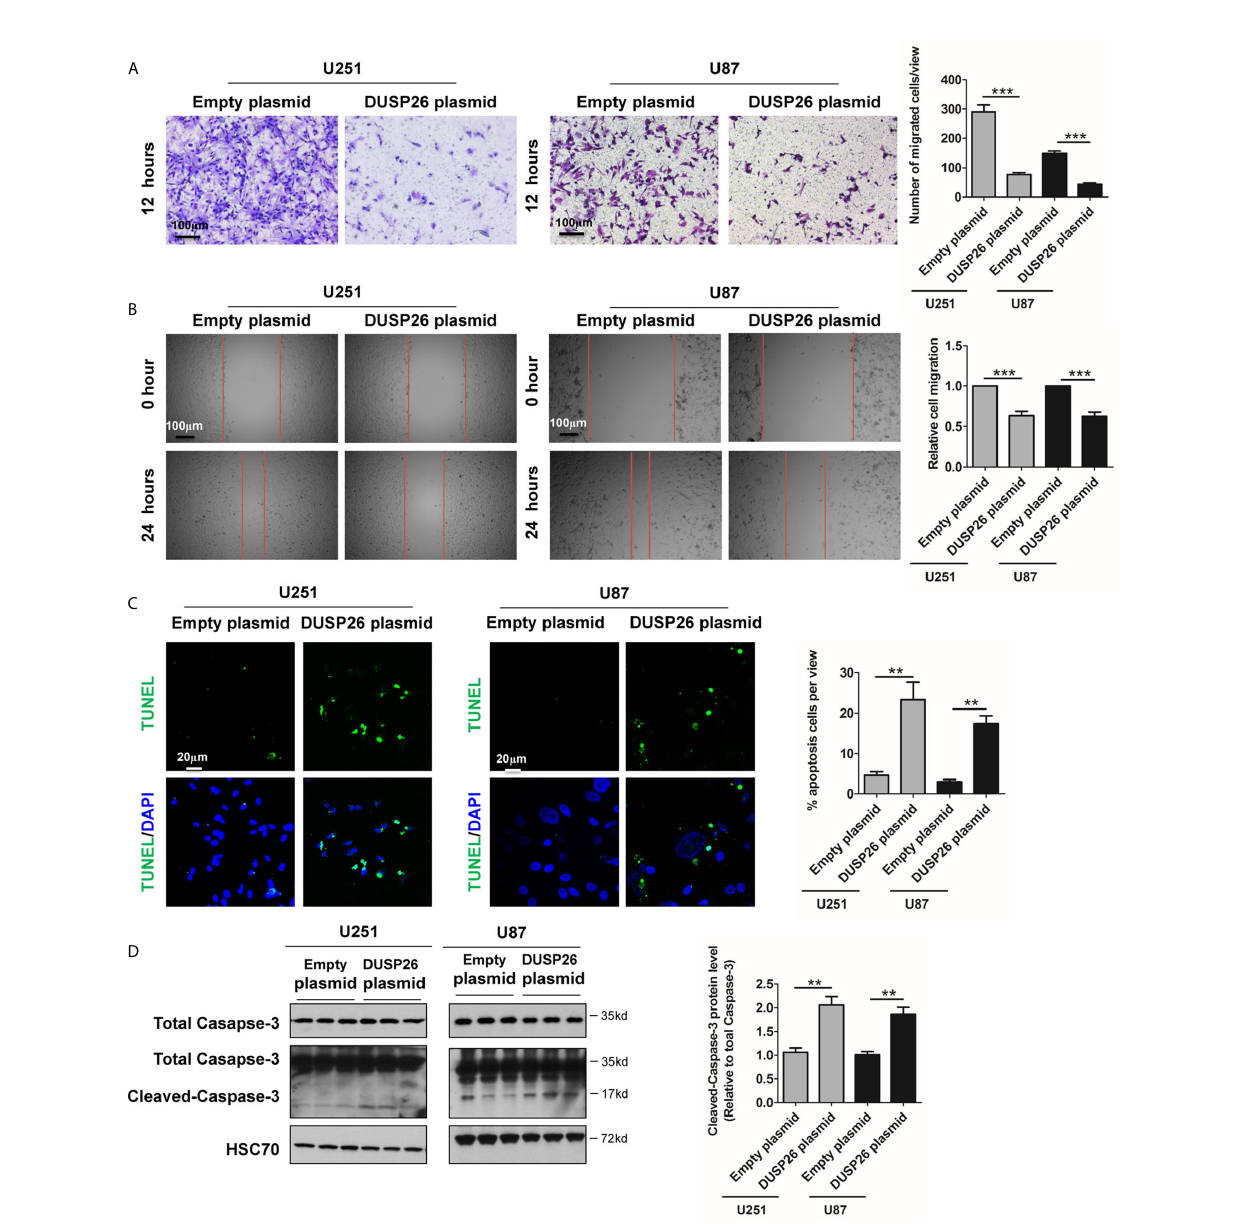
FIGURE 4 | Effect of DUSP26 overexpression on cell migration and apoptosis in glioblastoma (GBM) cells. (A) Representative images (left side) and graphs (rightside) showing relative cell migration as determined by transwell migration assays using U251 and U87 cells transfected with an empty plasmid or DUSP26 expression plasmid. Cells were allowed to migrate for 8 h. Cells migrated cells were stained and imaged under a microscope using 10X objective lenses and quanti fi ed. (B) Photomicrographs showing relative wound healing at 0 and 24 h after the wound was scratched in monolayers of U251 and U87 cells transfected with an empty plasmid or DUSP26 expression plasmid wound closure was measured and quanti fi ed. (C) Representative images (panels on the left side) and graphs of quanti fi cation (panel on the right side) of apoptotic cells detected by TUNEL assay performed using U251 and U87 cells transfected with an empty plasmid or DUSP26 expression plasmid. (D) Representative images of western blots (panels on the left side) and showing levels of total caspase-3, cleaved caspase-3 in lysates of U251 or U87 cells transfected with empty vector or DUSP26 plasmid construct, and lysed 48 h after transfection were analyzed in triplicate, HSC70 was used as loading control; graphs depicted on the right side show the quanti fi cation of cleaved caspase-3. **p < 0.05; ***p <